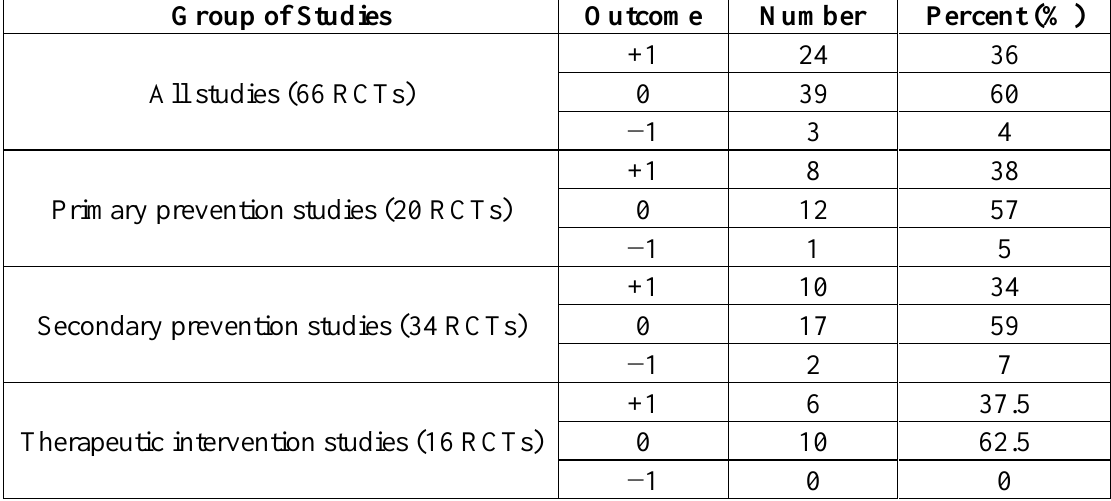
Table 1. Study outcome (intervention effects of antioxidant trials) with respect to primary goal and study